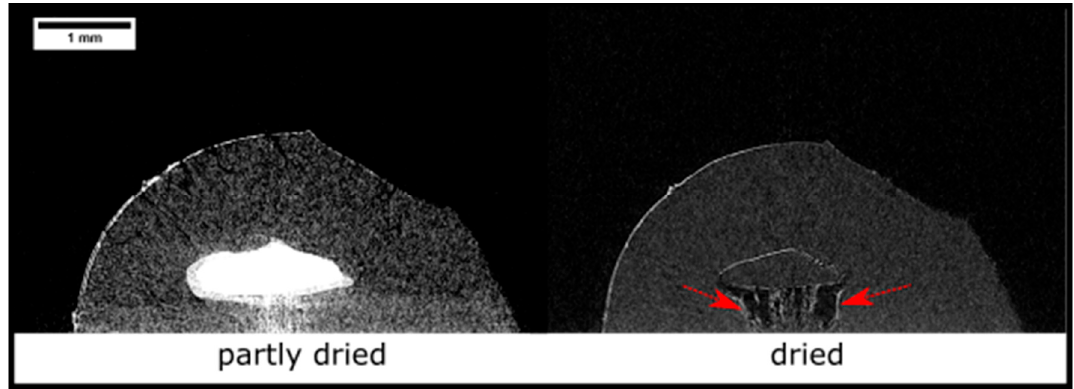
Figure 4. Partly dried and dried sectional view of a 20% (w/w) maltodextrin particle. Before (L) and after (R) a structural collapse.